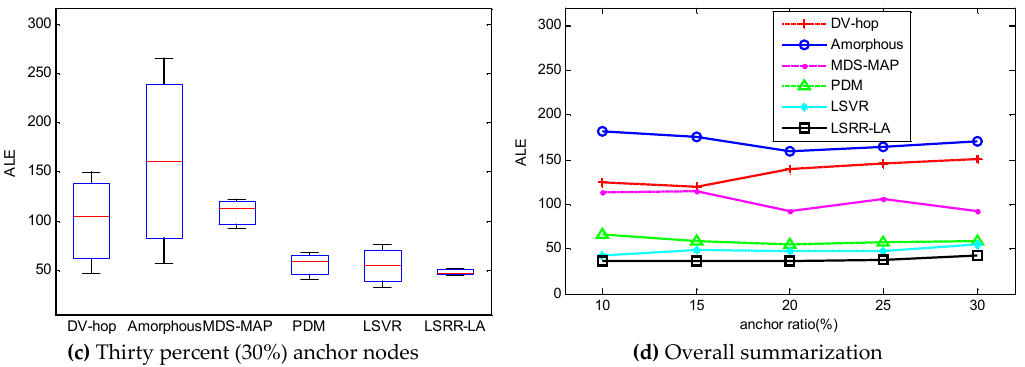
Figure 12. Comparison of the ALE under various anchor populations.